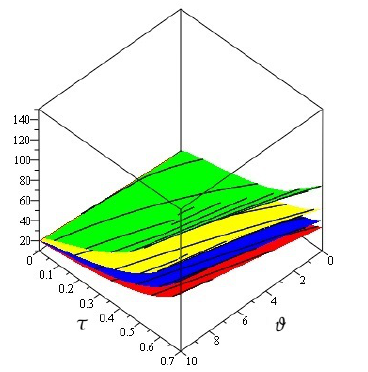
Figure 3. The different fractional-order of (cid:36) of ν ( ϑ , ζ , τ ) of Example